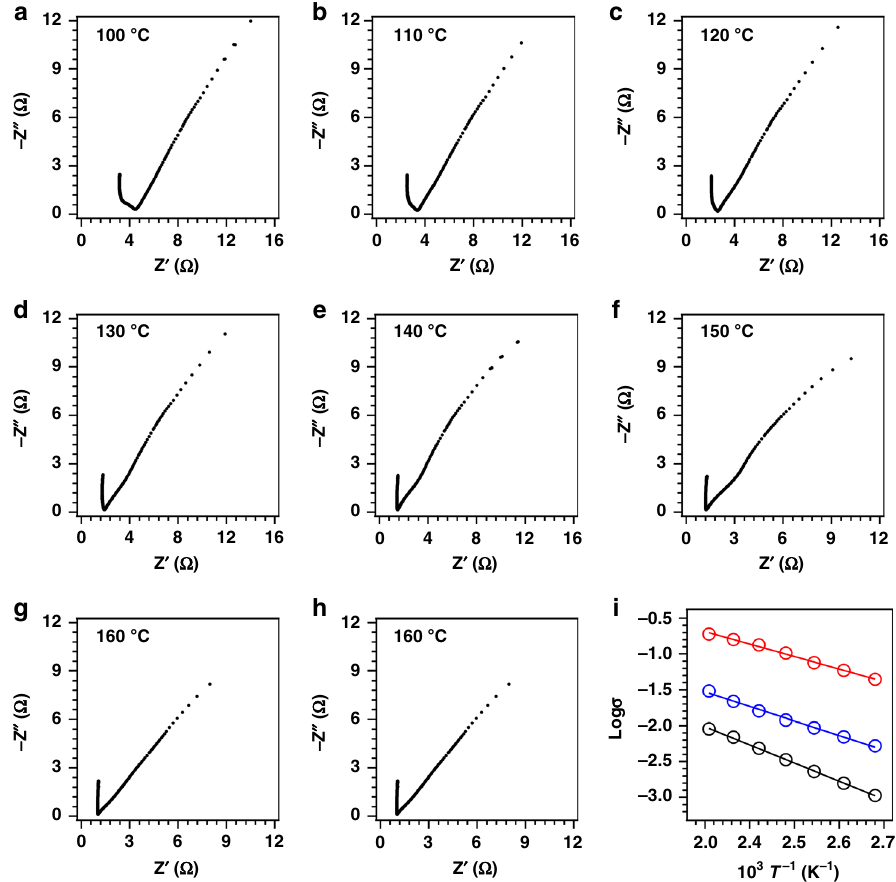
Fig. 4 Proton transport and activation energy. a – g , Nyquist plots of H 3 PO 4 @TPB-DMeTP-COF measured at different temperatures under anhydrous conditions. h Nyquist plot of H 3 PO 4 @TPB-DMeTP-COF after 20-h continuous run at 160 °C. i Temperature pro fi les of proton conductivities of H 3 PO 4 @TPB-DMeTP-COF (red circles and line), 75%H 3 PO 4 @TPB-DMeTP-COF (blue circles and line) and 50%H 3 PO 4 @TPB-DMeTP-COF (black circles and line). Circles are experimental data and lines are curve fi